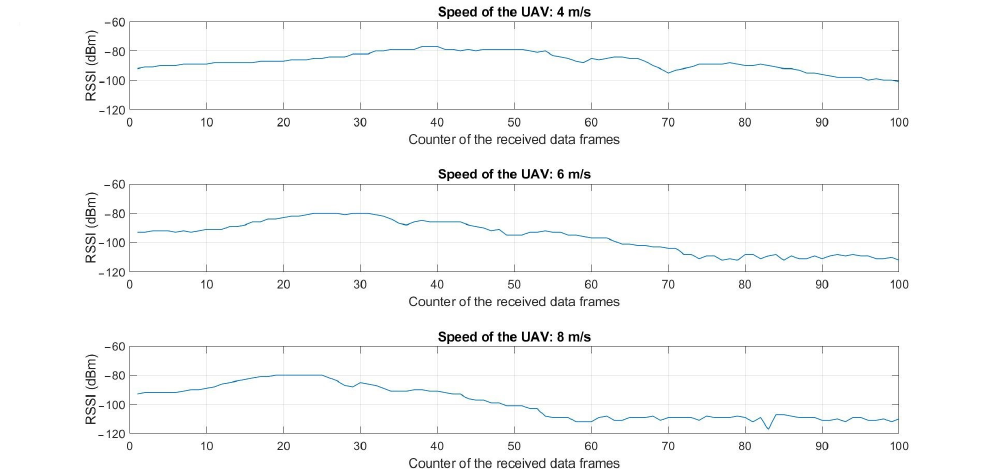
Figure 17. RSSI levels measured by the collector node when the UAV was flying along the trajectory of 200 m at respectively 4 m/s, 6 m/s and 8 m/s. 100 data frames were collected at each